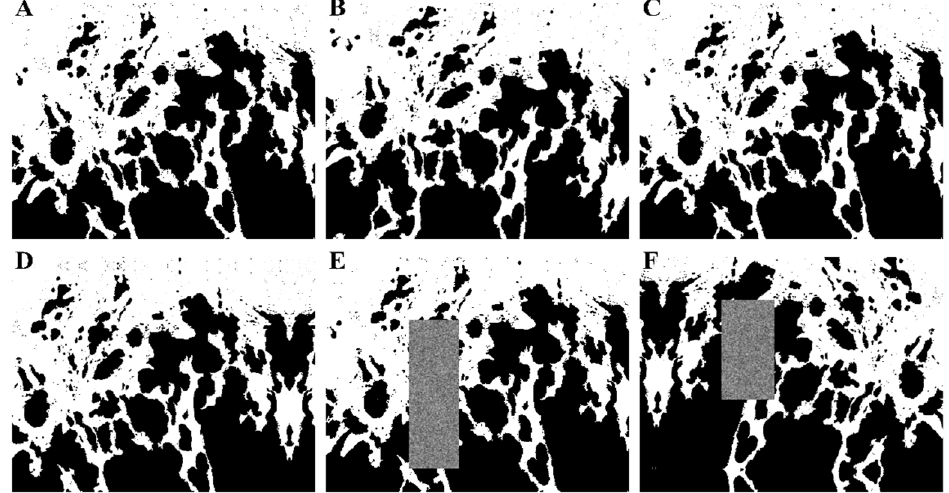
Figure 2. Different augmentations of the original image ( A ) through rotation ( B ), shearing ( C ), shifting ( D ), random erasing ( E ), and a combination of all methods ( F ).